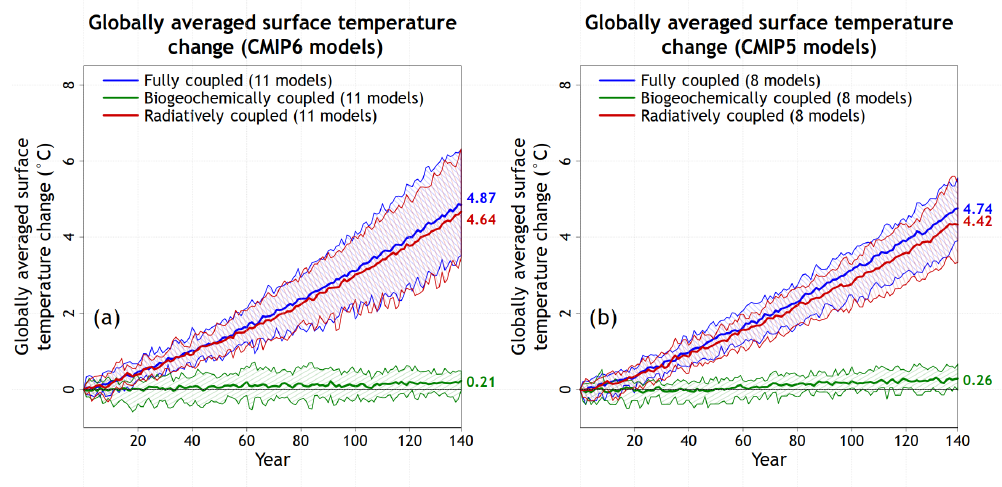
Figure 1. Temperature changes in the fully, biogeochemically, and radiatively coupled configurations of the 1pctCO2 experiment across participating CMIP6 (a) and CMIP5 (b) comprehensive ESMs that participated in this and the A13 study, respectively. The model mean is indicated by the solid lines, and the range across the models is indicated by shading around the solid lines. Individual CMIP6 model results are shown in Fig. A1 in the